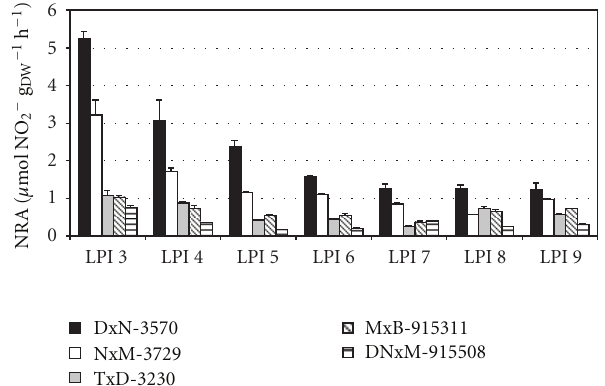
Figure 3: E ff ect of leaf age (developmental stage) on nitrate reduc- tase activity (NRA) of five hybrid poplar clones. Leaf plastochron index (LPI) is used as an indicator of leaf age. All data points are means of duplicate sample analyses and vertical bars represent SD of the